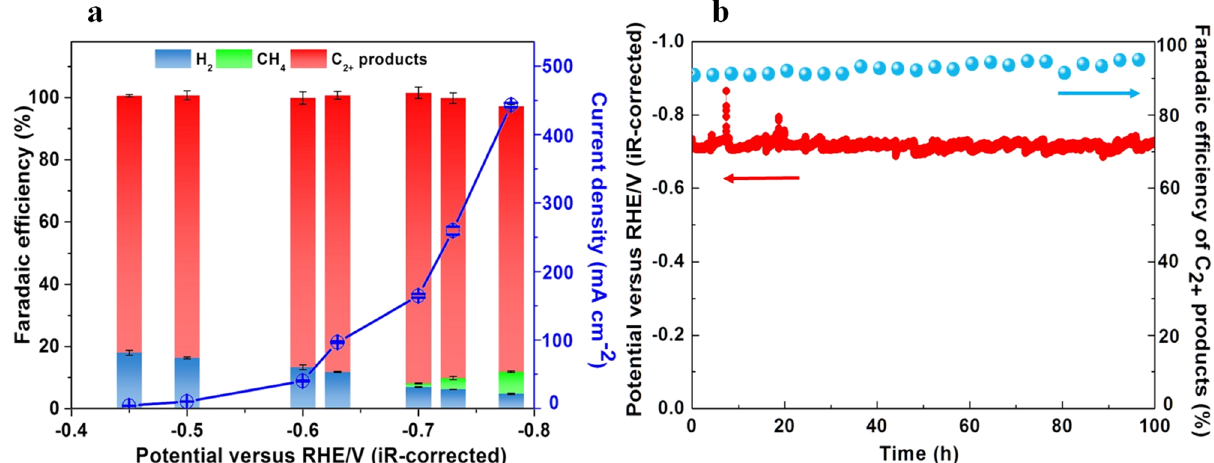
b Stabilitytestoveraspanof100hofelectrolysisat164mAcm − 2 in2.0MKOH.The loading of Cu/Cu 2 O-A is 2mgcm − 2 . Error bars represent the standard deviations calculated from three independent